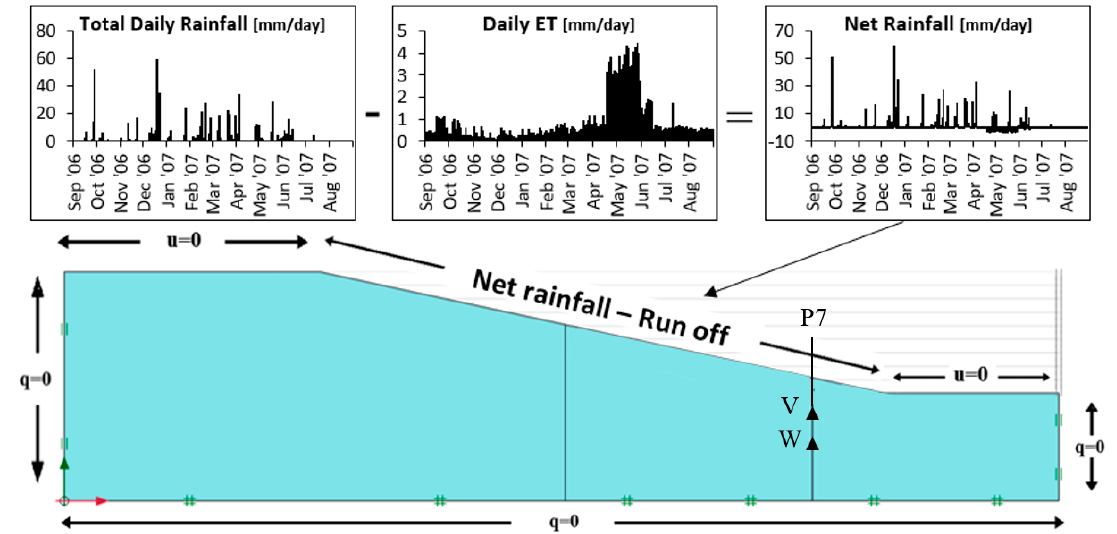
Figure 11. Analysis of the SLVA interaction: hydromechanical boundary conditions.